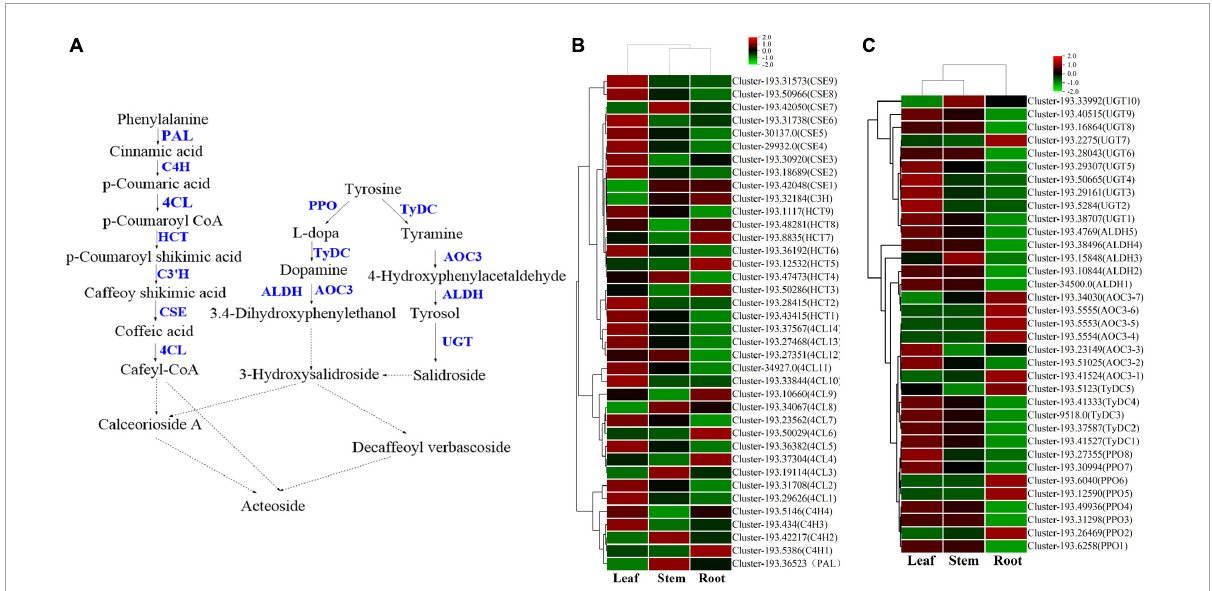
FIGURE9 The phenylethanoid glycosides biosynthesis pathway and the heatmap of corresponding genes in Verbena officinalis . (A) Predicted biosynthetic pathways of phenylethanoid glycosides. Compounds are in black, enzyme names are in blue. The solid arrows are the processes that have been reported, and the dashed lines have not been reported. (B) Heatmap of phenylalanine metabolic pathway DEGs. (C) Heatmap of dopamine/tyramine pathway DEGs.